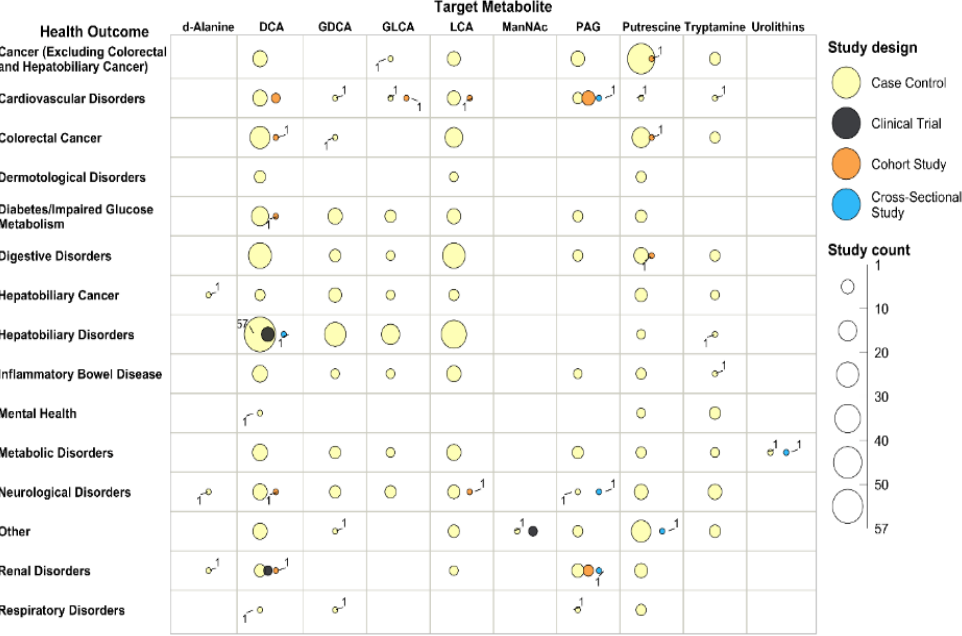
Figure 4. Bubble Plot for Relationships or Pattern between Metabolites, Health Outcomes, and Study Design with Bubble Size Relative to Number of Participants. Abbreviations: DCA: Deoxycholate